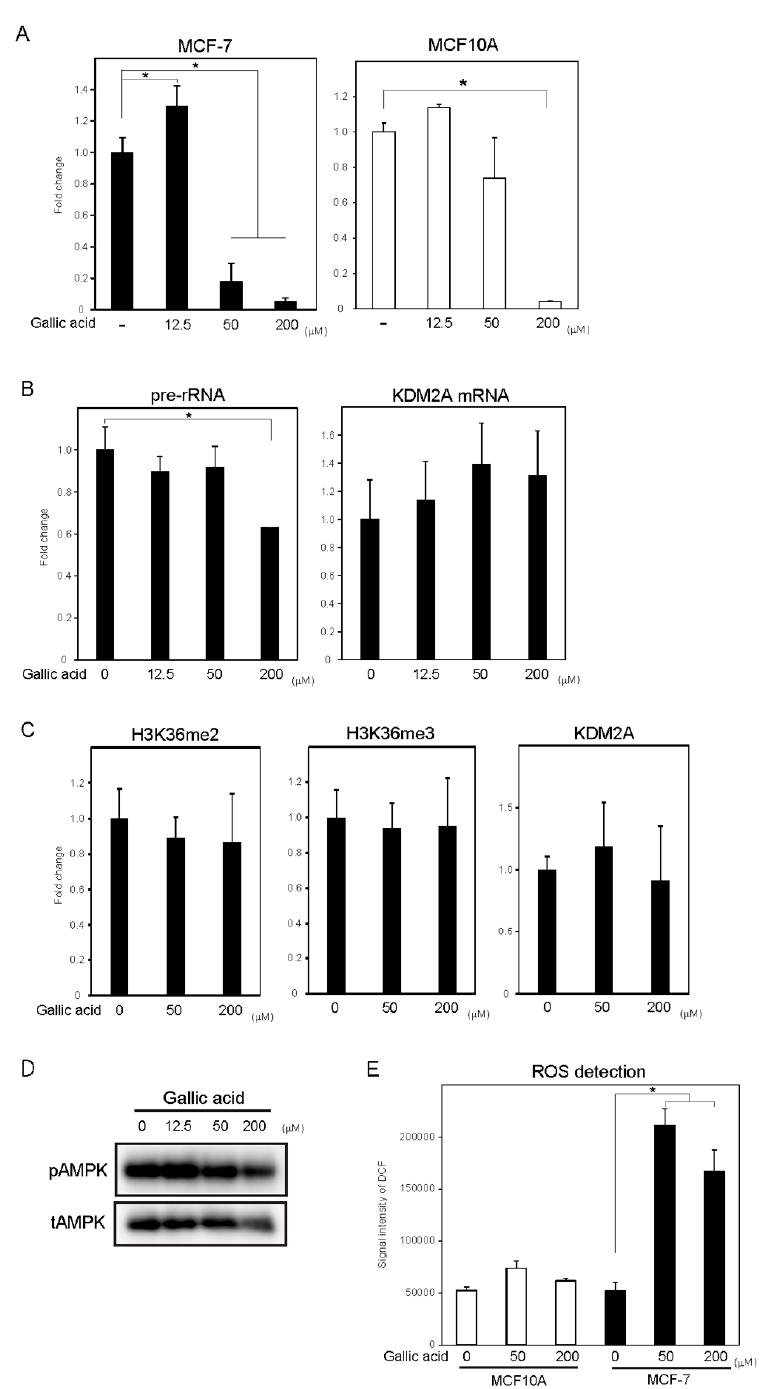
Figure 4. Gallic acid does not induce KDM2A activity to reduce cell proliferation in non-tumorigenic MCF10A cells. ( A ) The effects of gallic acid on cell proliferation of MCF10A cells. MCF-7 cells and MCF10A cells were treated with gallic acid as indicated concentrations. After culture for 2 days, cell numbers were analyzed by the same method as Figure 1A. The experiments were performed four times ( n = 4), and the mean values with standard deviations are indicated. * p < 0.05. ( B ) The effects of gallic acid on rRNA transcription in MCF10A cells. The MCF10A cells were treated with gallic acid as indicated concentrations for 4 h. Total RNAs were isolated and analyzed by qRT-PCR to detect pre-rRNA (left panel) and KDM2A mRNA (right panel). The ratios of the values for cells treated with various concentrations of gallic acid to those for cells treated without gallic acid are shown. The experiments were performed three times ( n = 3), and the mean values with standard deviations are indicated. * p < 0.05. ( C ) The effects of gallic acid on H3K36me2 mark in the rDNA promoter of MCF10A cells. MCF10A cells were treated with gallic acid